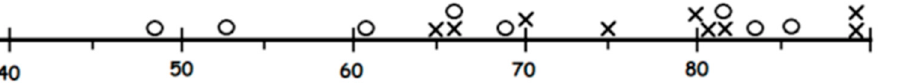
Figure 12. One-dimensional scatter graph with first symptom to death below and above average Figure 12. One ‐ dimensional scatter graph with first symptom to death below and above average categories. categories.